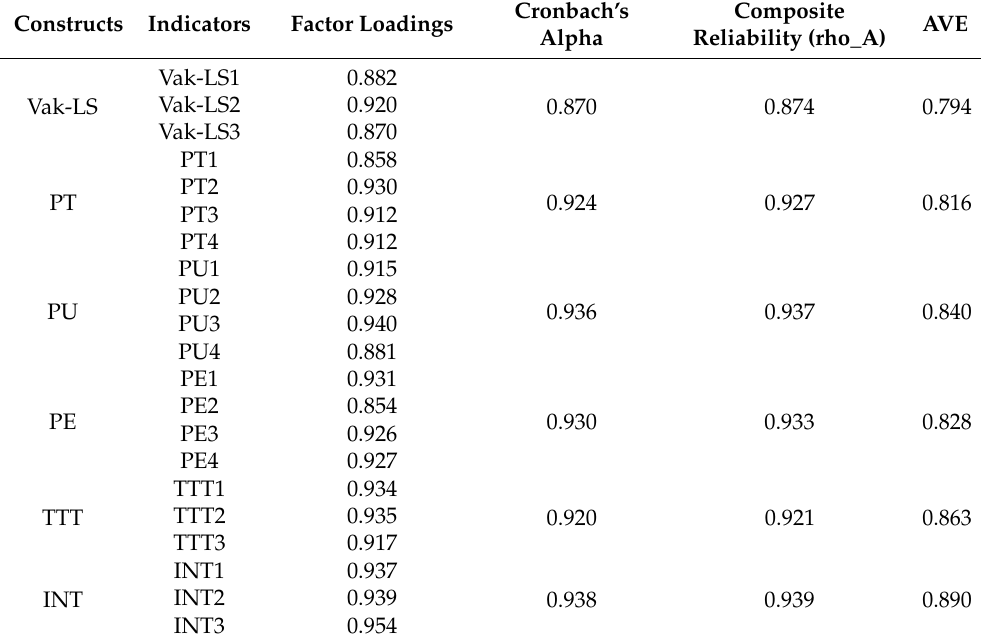
Table 3. Assessment of reflective measurement models.